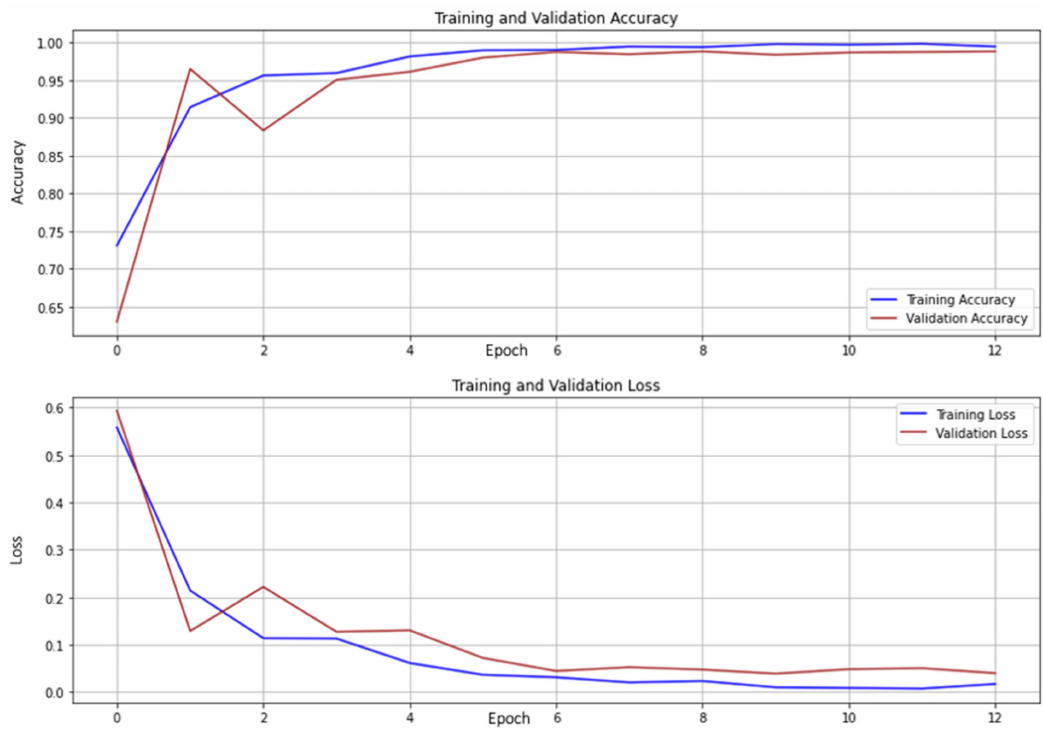
Figure 7. Monitoring the accuracy and loss of the training and validation